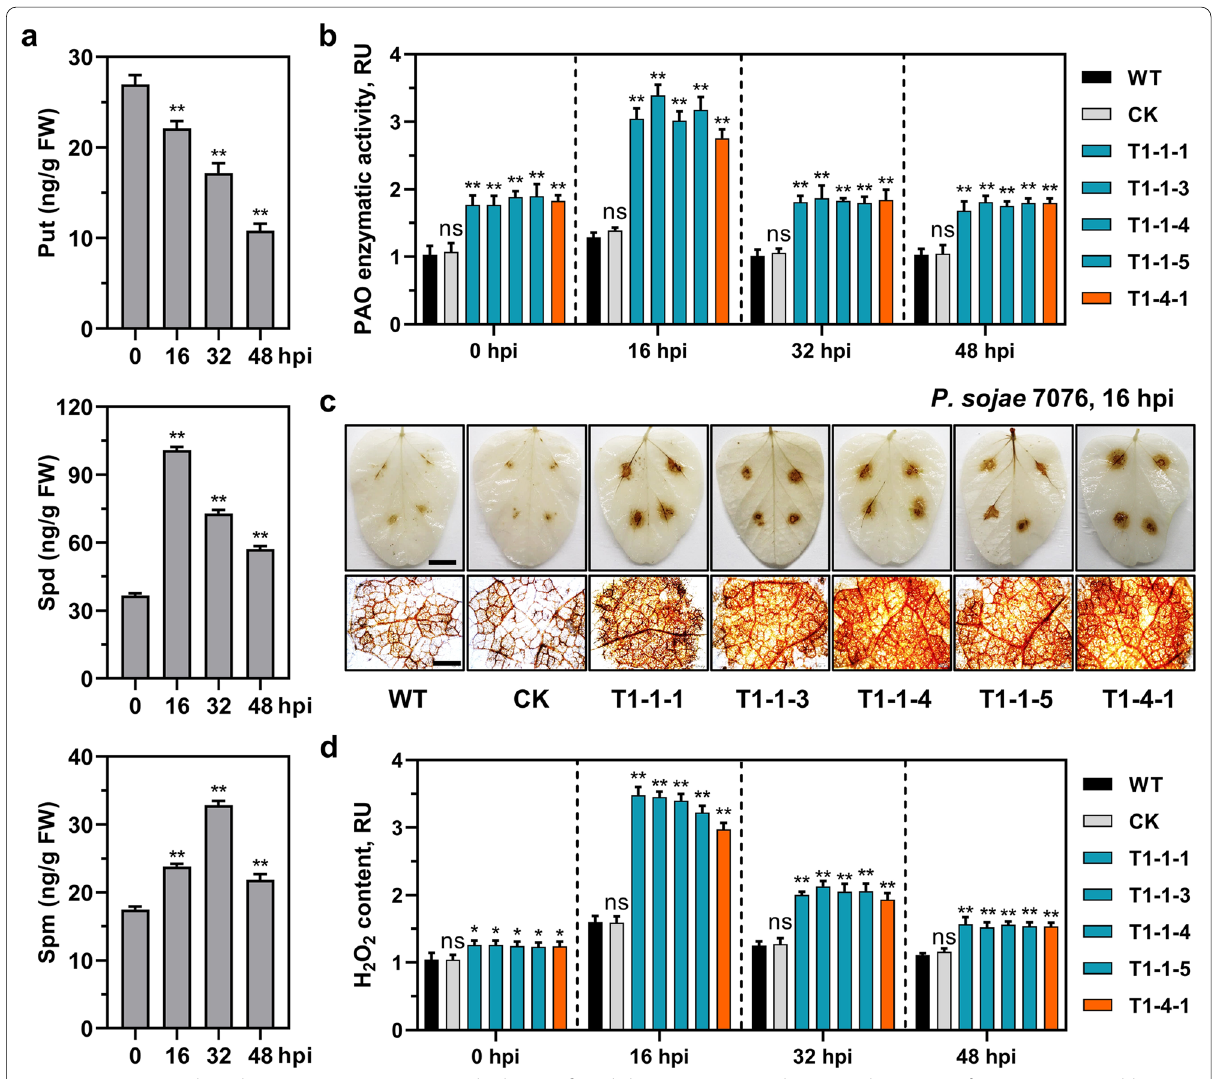
Fig. 1 Transgenic soybean lines overexpressing GmPAO display significantly boosting H 2 O 2 production at the P. sojae infection sites. WT: wild-type soybean cultivar Williams 82; CK: non- GmPAO transgenic soybean line. T1-1 (including T1-1-1, T1-1-3, T1-1-4, and T1-1-5) and T1-4-1 are progenies of two independent transgenic soybean lines overexpressing GmPAO gene. a Changes in the contents of putrescine (Put), spermidine (Spd), and spermine (Spm) in WT plants in response to P. sojae infection. Error bar represents mean PAO enzymatic activity and H 2 O 2 content in transgenic soybean plants during P. sojae infection. RU: relative activity units (Error bar represents mean SD, n 3, n represents sample number). c DAB staining of H 2 O 2 at 16 hpi. Scale bar: 1 cm (upper). Micrograph of DAB staining at P. sojae ± = infection sites. Scale bar: 20 μm (lower). All the experiments were performed three times (biological replicates) with similar results. The data in a, b, and d were analyzed by Shapiro–Wilk test to determine the Normality and Lognormality Tests across groups, and then analyzed by one-way ANOVA with post-hoc Dunnett’s multiple comparisons test for groups that had passed the normality test (ns, no significant difference; * P < 0.05; ** P < 0.01). The exact n, SD values, and P values are shown in the